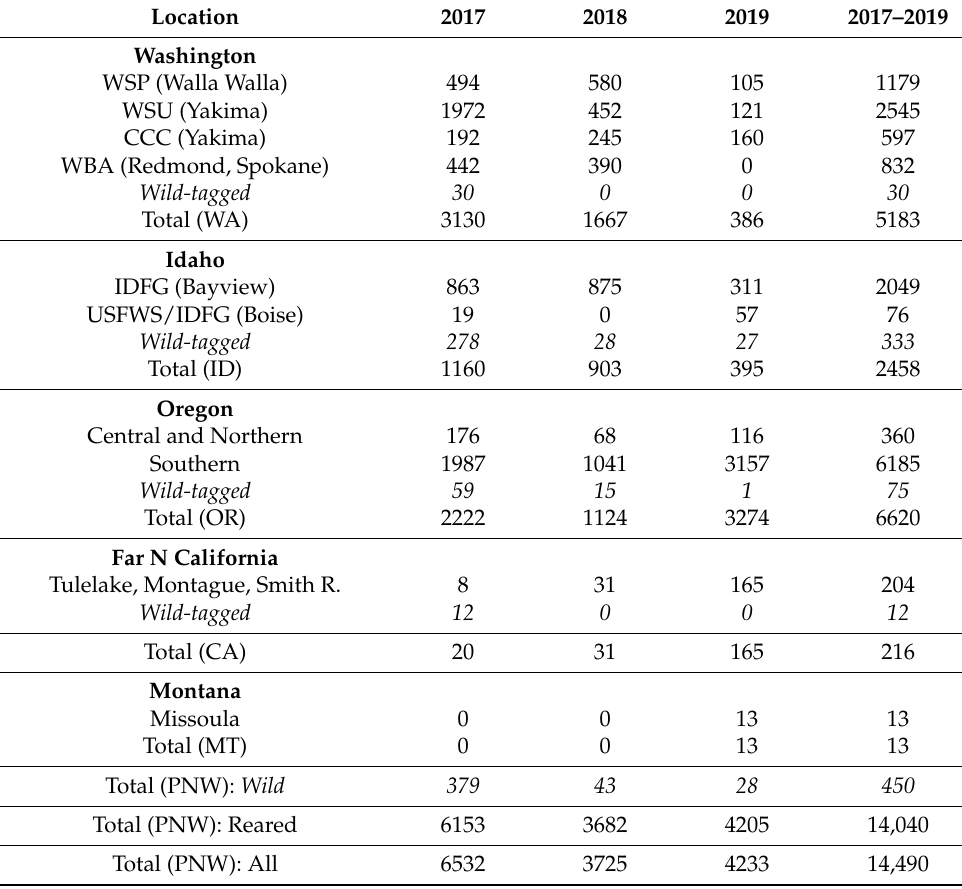
Table 1. Numbers of monarchs, captive-reared and tagged and wild-tagged by organizations and citizen scientists during 2017–2019 (WSP = Washington State Penitentiary, WSU = Washington State University, CCC = Cowiche Canyon Conservancy, WBA = Washington Butterfly Association, IDFG = Idaho Fish and Game, USFWS = United States Fish and Wildlife Service. Italics separate wild-tagged from